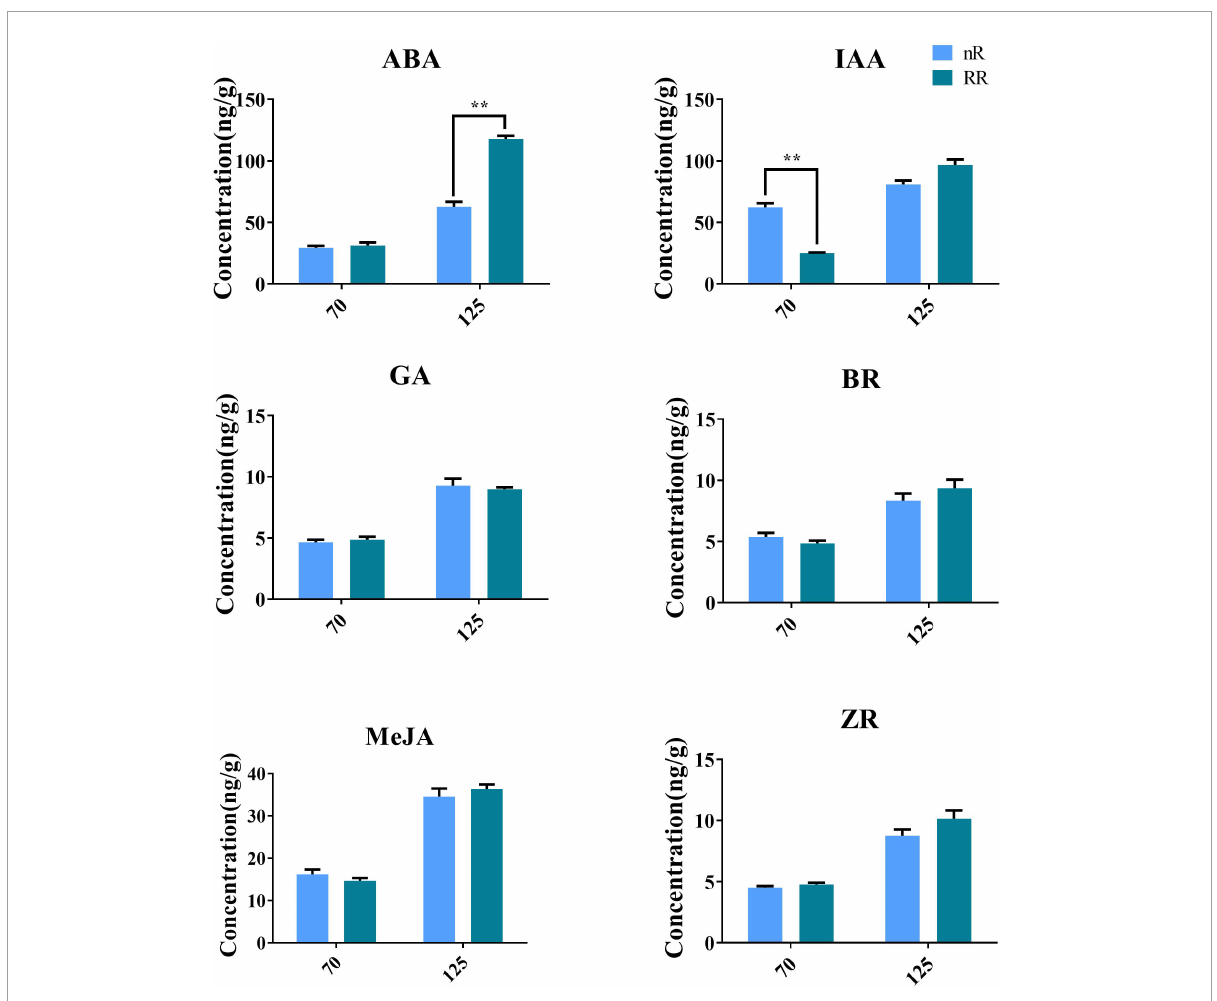
FIGURE8 Effect of RR treatment and nR treatment on the contents of endogenous phytohormones in grapevine roots of different developmental stages. A total of six phytohormones were detected in this study, including ABA, IAA, MeJA, GA, BR, and ZR. The ** indicated whether there is a significant difference between the two